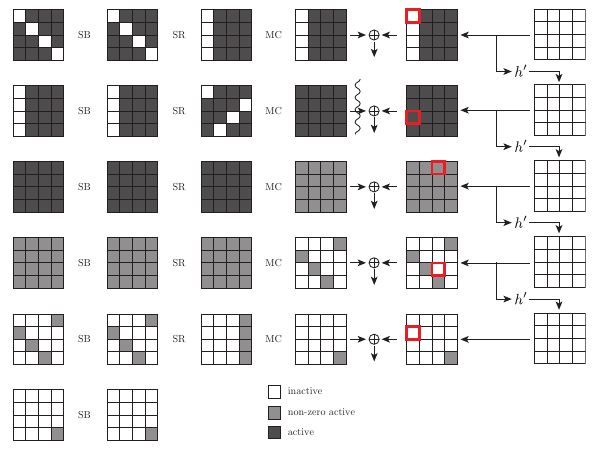
Figure 23: Verification of our distinguisher for